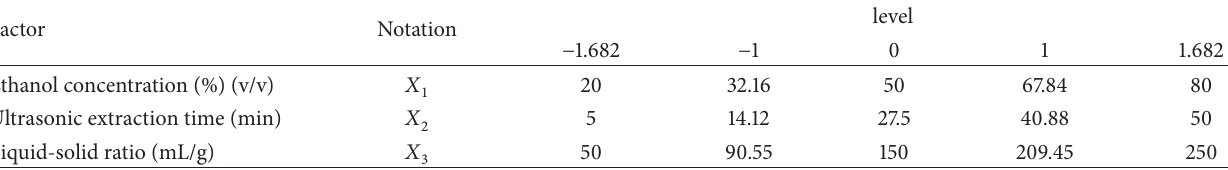
Table 1: Independent variables and their levels used in the response surface